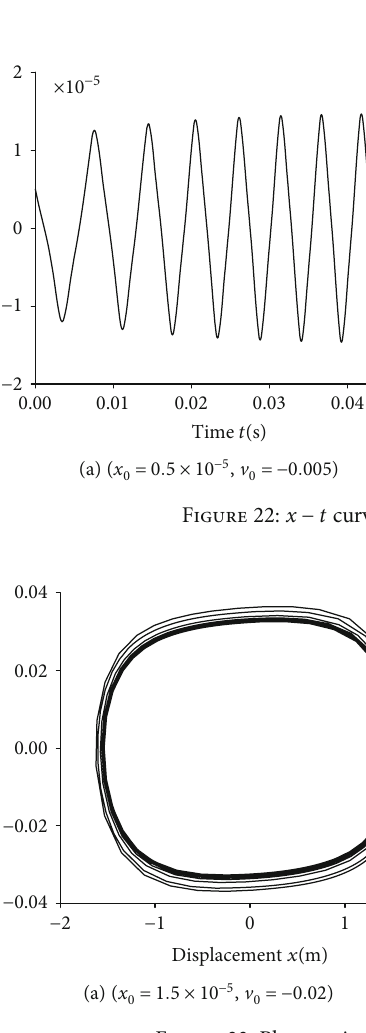
Figure 23: Phase trajectories under i